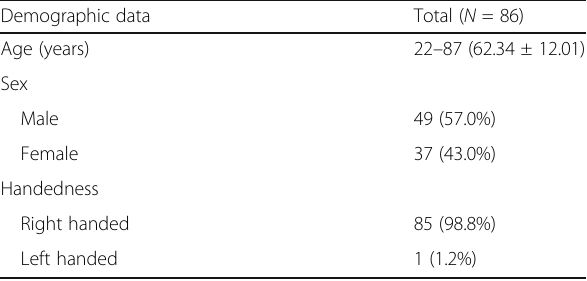
Table 3 NIHSS total and language subscale scores among